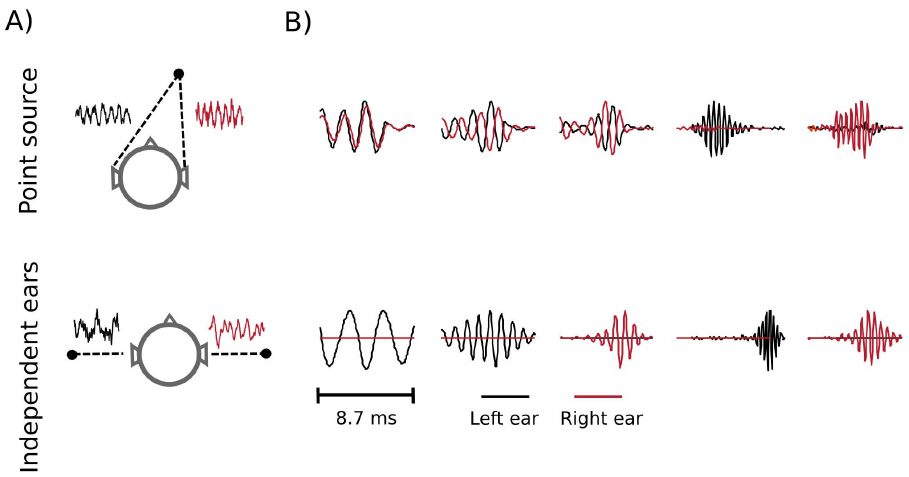
Figure 11. Independent components of simulated data. A) Cartoon illustrations of the generation process of the maximally dependent (top) and the maximally independent (bottom) datasets. B) Exemplary ICs trained on simulated data (point source data - top row, independent ears data - bottom row). If binaural sounds had the same underlying cause, vectors corresponding to each ear captured the signal structure. In the independent ear setting, one of the monaural parts of every IC was always flat.